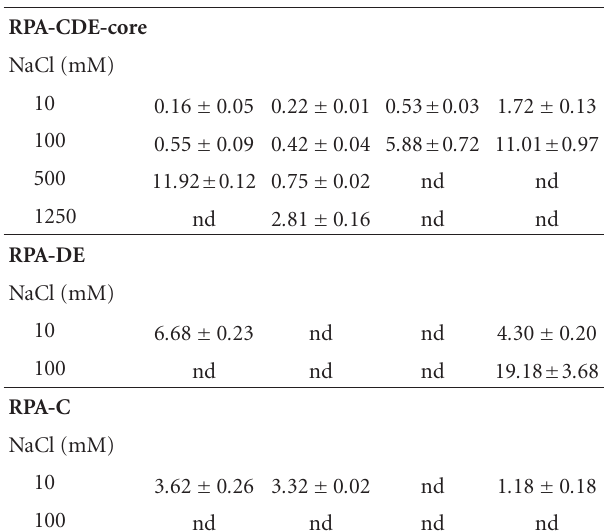
Figure 3: CD characterization of the Gq23 and TC23 oligonu- cleotides. (a) Antiparallel model of Gq23 (G black, T red, and A green). Note, the third G-quartet stack (from the top) contains an A instead of the canonical G. Pink circles indicate sodium ions that aid in G-quartet formation and stacking. This hypothetical model shows just one of several possible base pairing arrangements for a Gq23 intramolecular quadruplex. (b) Spectra of Gq23 recorded in a 1cm cuvette at 25 ◦ C in 100 mM NaCl (black), 10mM NaCl (red), and the TC23 sequence in 100 mM NaCl (dashed blue).